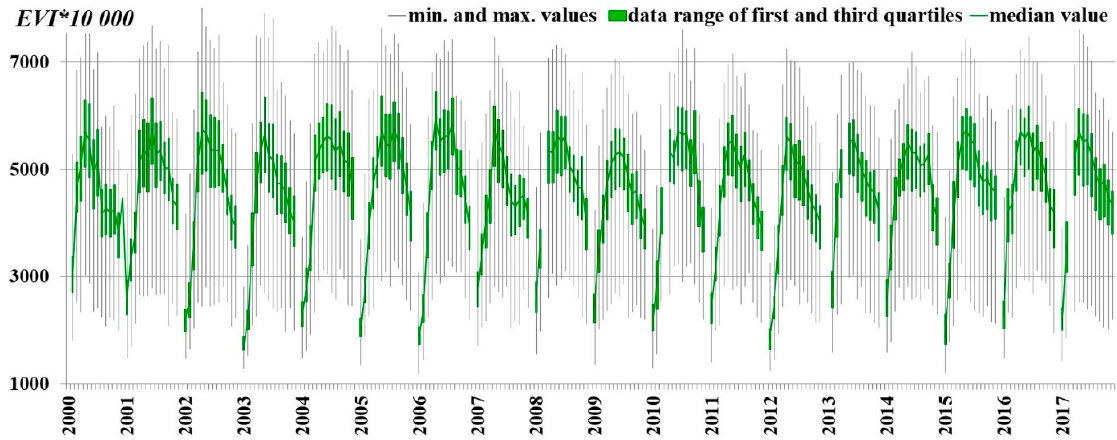
Figure 4. Deciduous forest EVI data time series based on MODIS MVC images for 16-day periods during the growing season (2000–2017) [52].